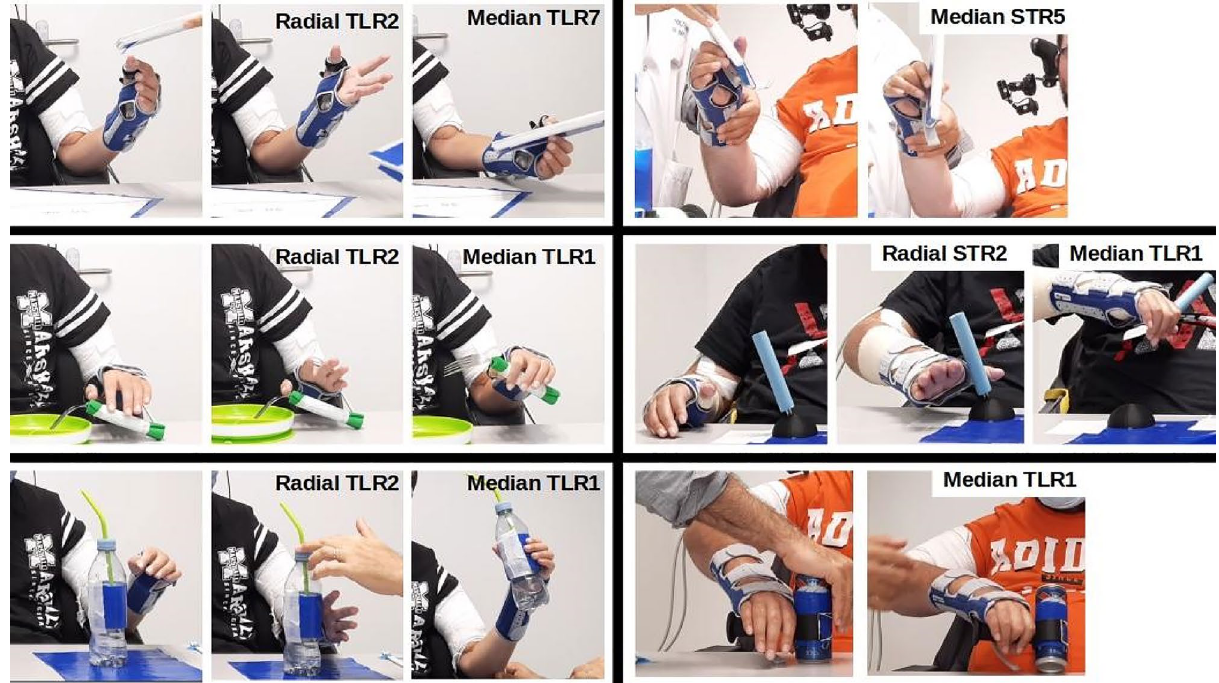
Figure 5. Video snapshots illustrating different grasping performances. Left: participant P1. Right: participant